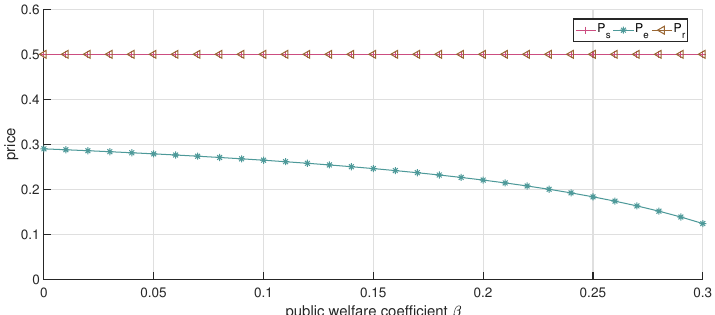
Figure 7. The impact of changes in β on service price (the dual-channel strategy p 0 = 0.5).